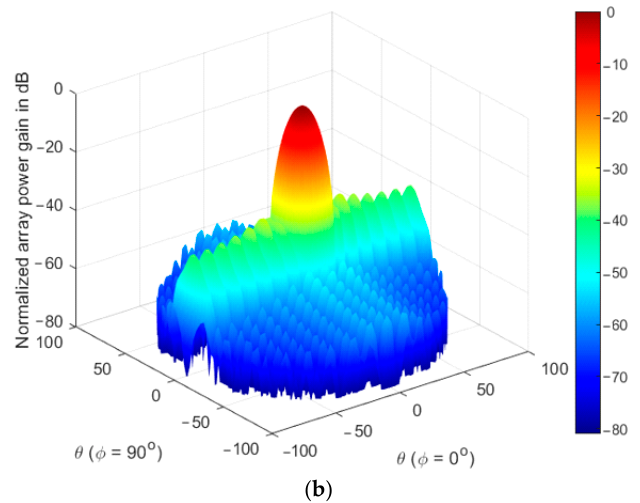
Figure 14. ( a ) 2D radial tapering extrapolated cosine-square window for 16 × 24 array. ( b ) Normalized array power pattern.